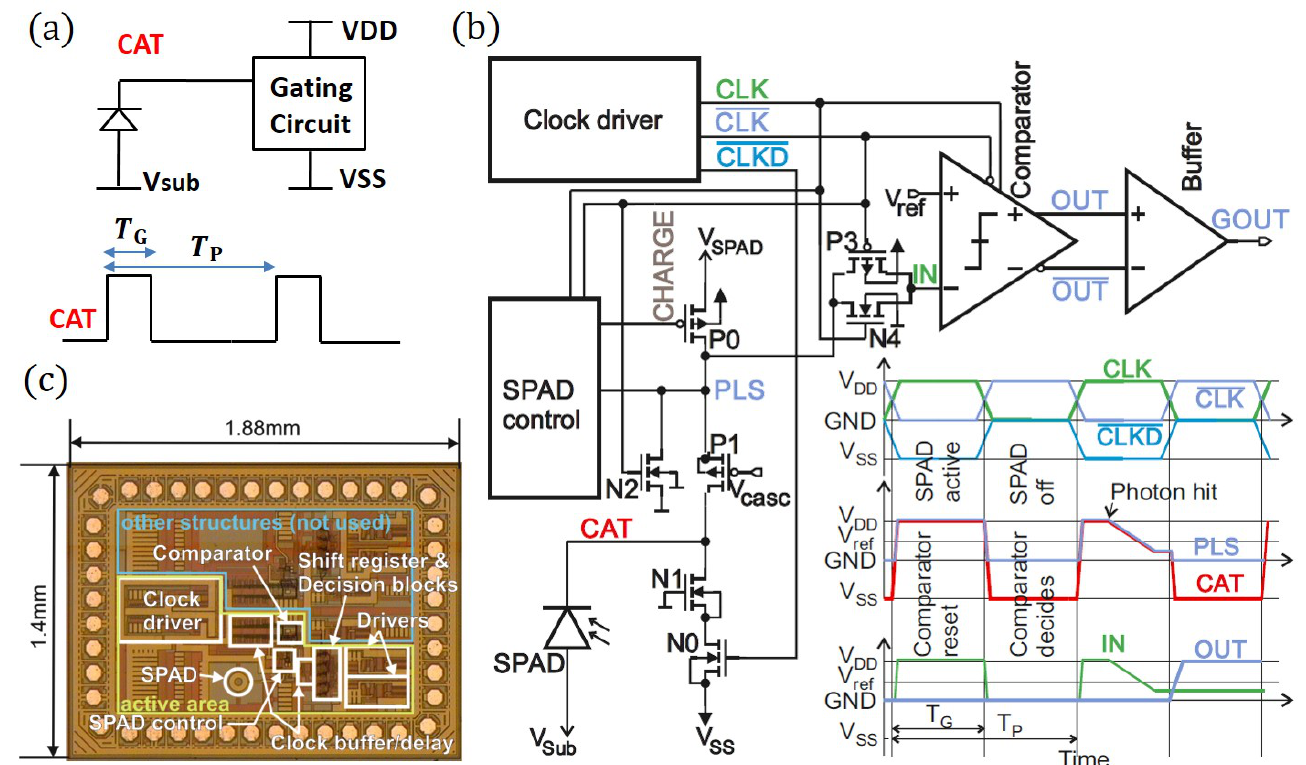
Figure 1. ( a ) Basic concept of the time-gated detection, ( b ) circuit block diagram, and ( c ) microphotograph of the fully integrated time-gated SPAD data receiver test chip [21]. The main supply voltages of the gating circuit are V DD = 3.3 V and V SS = − 3.3